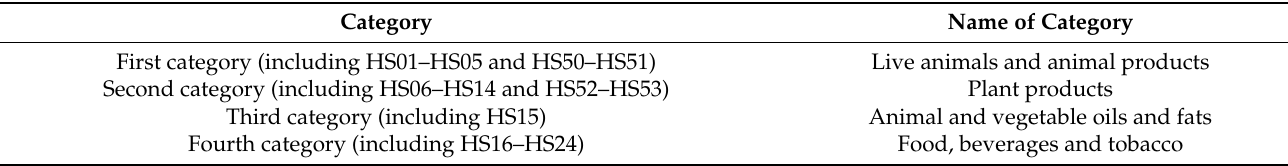
Table 4. The 4 categories of agricultural products based on the 28 varieties of agricultural products at HS 2-digit